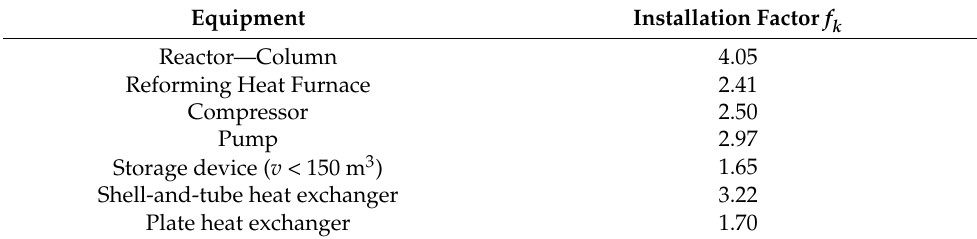
Table 5. Installation factors for different equipment